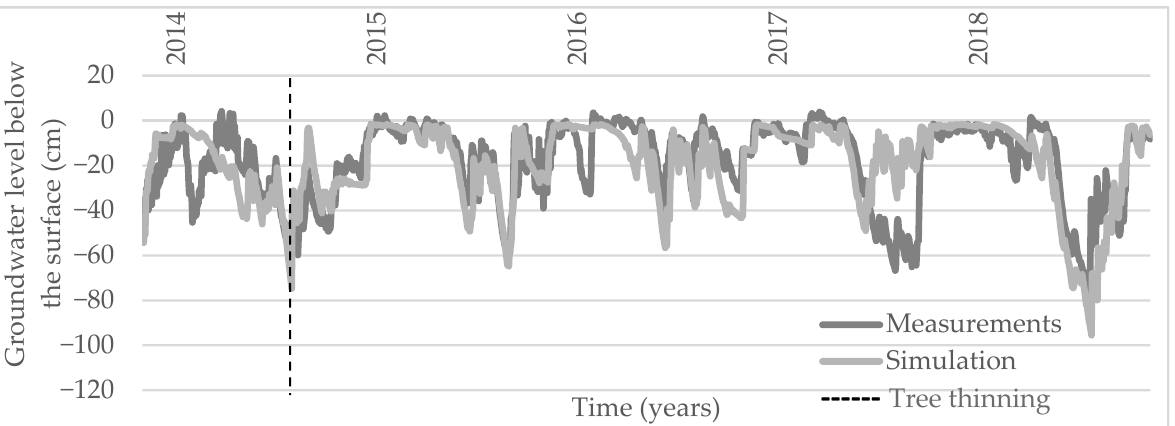
Figure 4. Measured vs. simulated groundwater level in plot 1. The groundwater curves of the plot 2 (Figure 5) reveal elevated groundwater levels in the post-thinning winter (2014/2015). On frozen ground there is no evaporation, but, unlike deciduous trees, conifers slowly transpire. Nevertheless, the peat layer loses less water. In summer, the impact of the decrease in transpiration on the total water